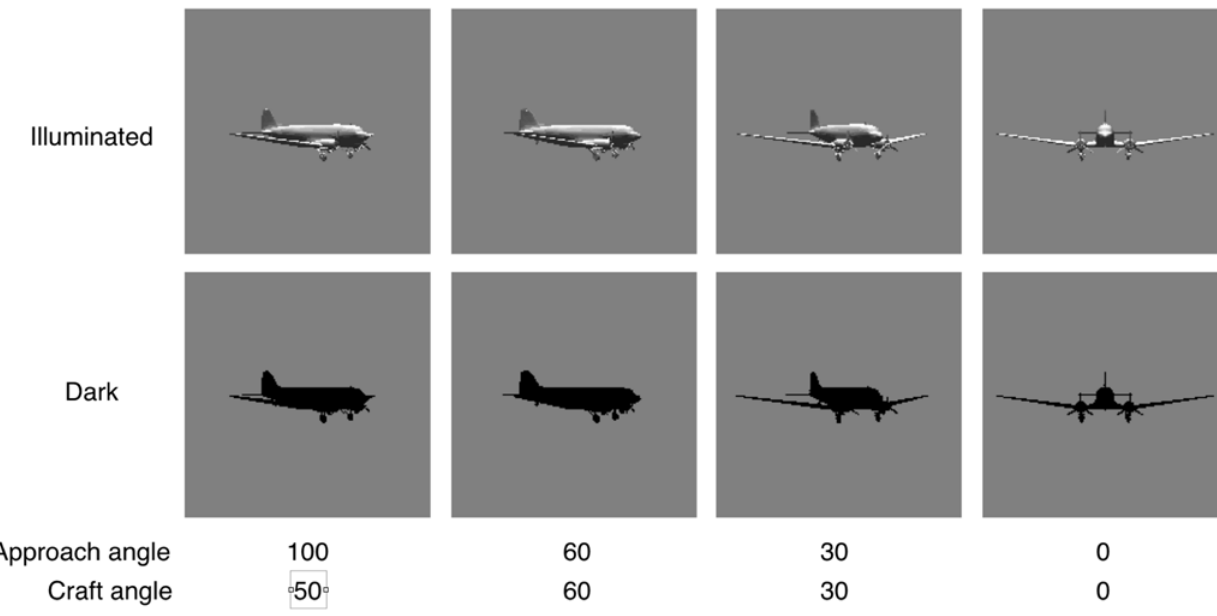
Figure 17. Rendered images of DC-3 aircraft at four approach angles and two illumination conditions. These are the approach angles used in the experiment of Howell [5].